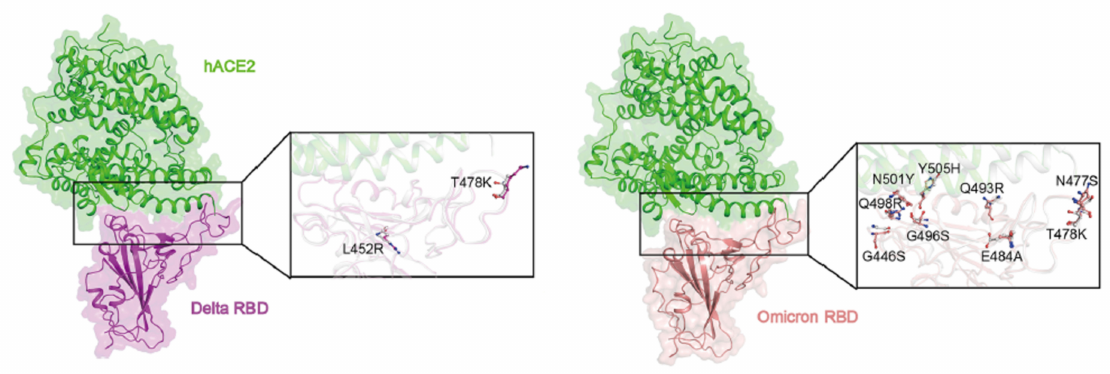
Figure 3. Mutations in the receptor binding domain of the Delta and Omicron variants. The Delta variant acquired key mutations such as L452R and T478K. The Omicron variant obtained important mutations such as Q493R, G496S and Q498R, which contributed to the enhanced infectivity and immune-evading capacity of the virus. Reprinted from Han et al. [86]. The permission to reprint was granted by Cell